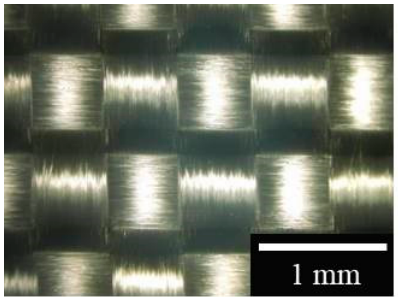
Figure 10. Photograph of the magnified surface of the E-glass cloth.